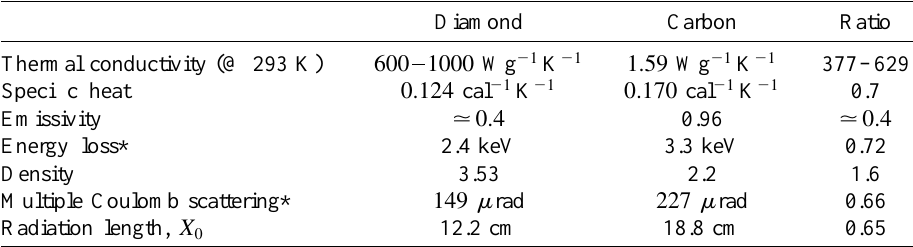
TABLE I. Comparison of parameters for a diamond and an amorphous carbon foil of the same thickness, 240 m g (cid:2) cm 2 , penetrated by protons of an energy of 40 MeV. The values denoted by an * are taken for a transverse energy corresponding to the angular divergence, including surface